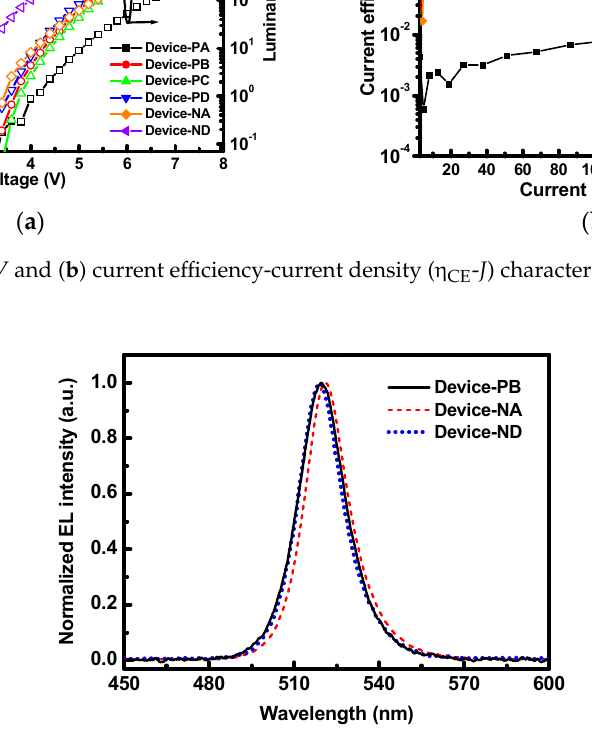
Figure 5. ( a ) L–J–V and ( b ) current efficiency-current density ( η CE - J ) characteristics of the PeLEDs.